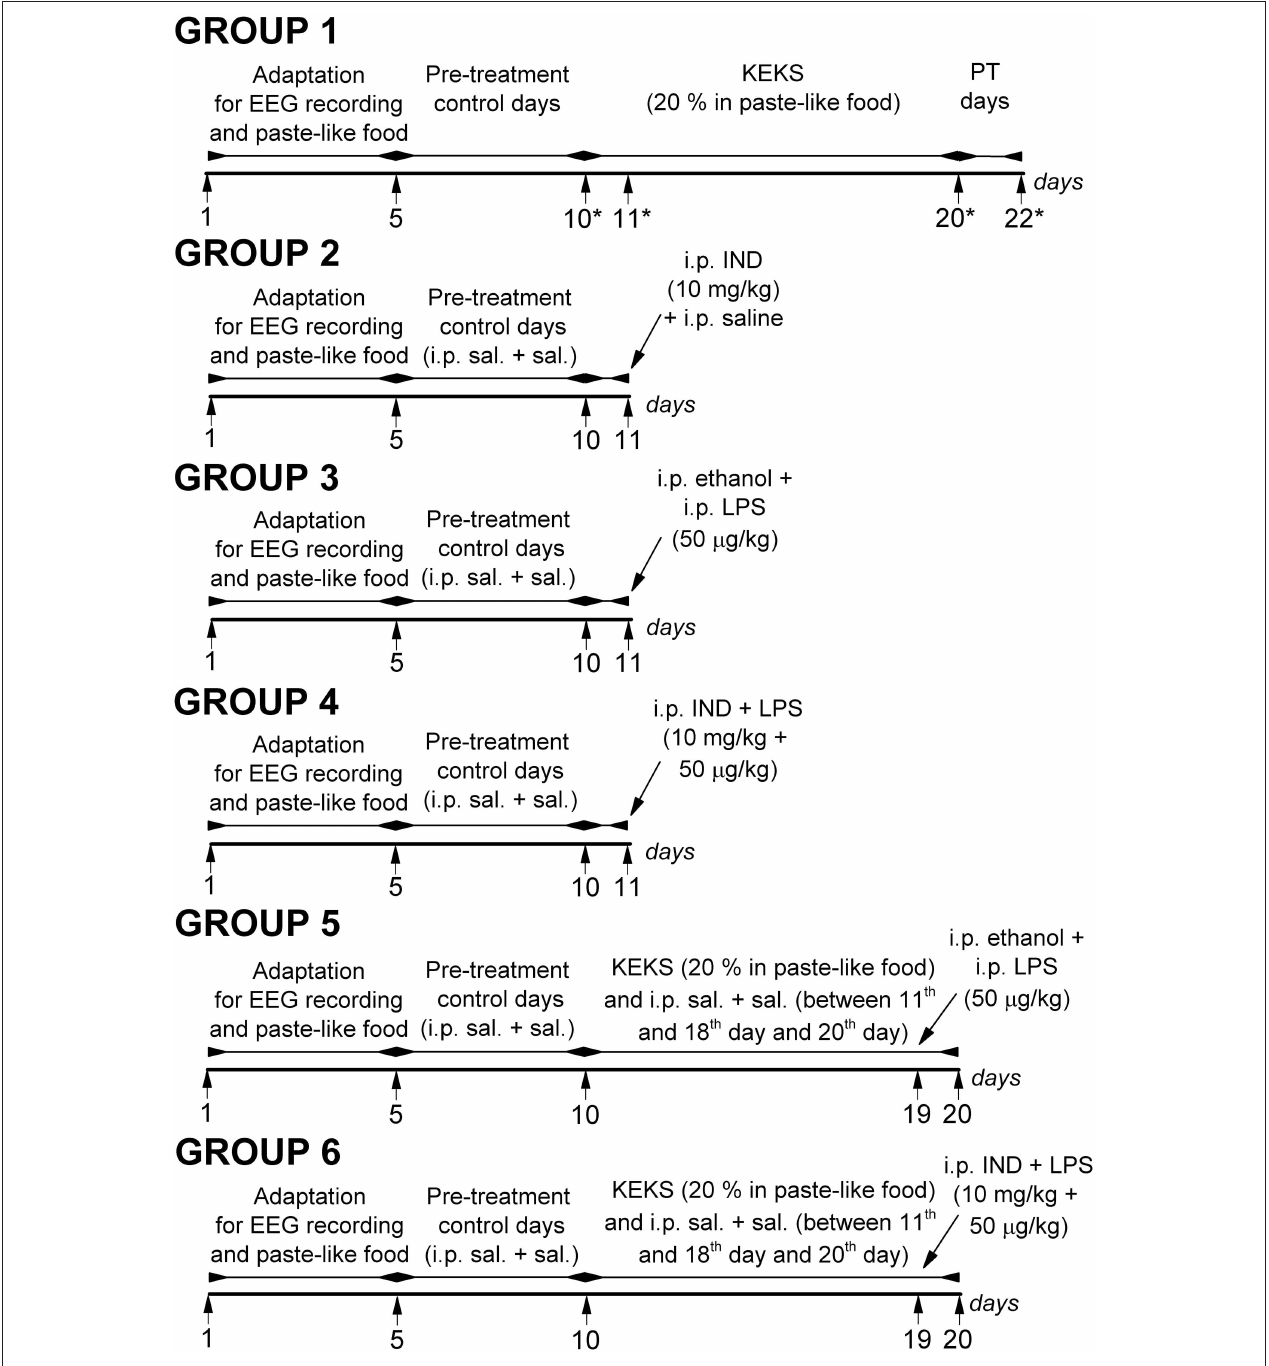
FIGURE 1 | Schematic drawing of the experimental design on 6 animal groups. *Days of blood glucose and β HB level measuring (group 1); IND, indomethacin; i.p. sal. + sal., IP 0.3ml saline/100g body weight (1st injection) followed by 0.3ml saline/100g body weight (30min later, 2nd injection); KEKS, ketone ester/KE + ketone salt/KS; LPS, lipopolysaccharide; PT days, post-treatment control days.